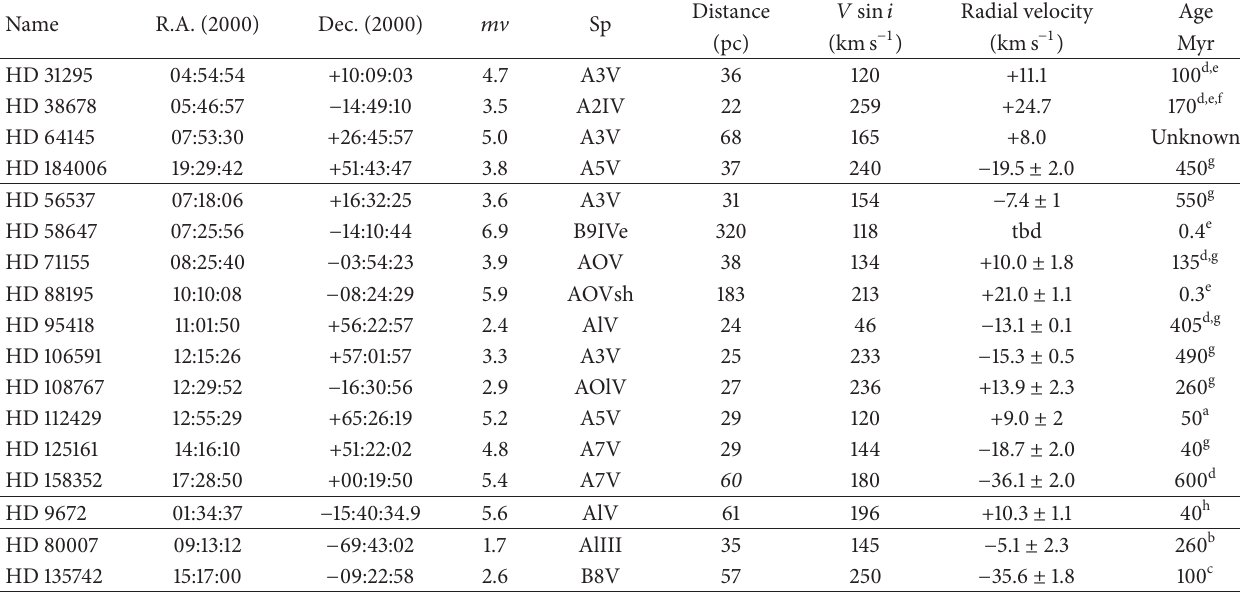
Table 1: Stellar target information.